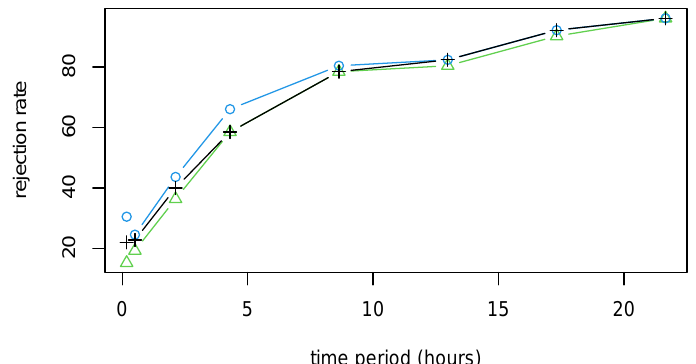
Figure 5. Display of the rejection rates in Table 6: the values labelled by no projection are in green triangles, those by with projection in back plus symbols and those by minimum with blue circles. The time period in the x-axis corresponds to the buoys in general. For the buoys in B , it is 4.34 min, 14.10 min, 1.05 h, 2.13 h, 4.30 h, 6.47 h, 8.64 h and 10.81